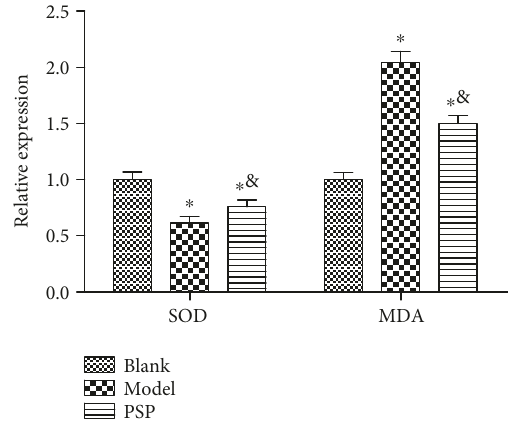
Figure 8: E ff ect of PSP on oxidative stress in NPCs of rats with degeneration of the intervertebral disc. ∗ P < 0 05 , compared with the blank group. & P < 0 05 , compared with the model